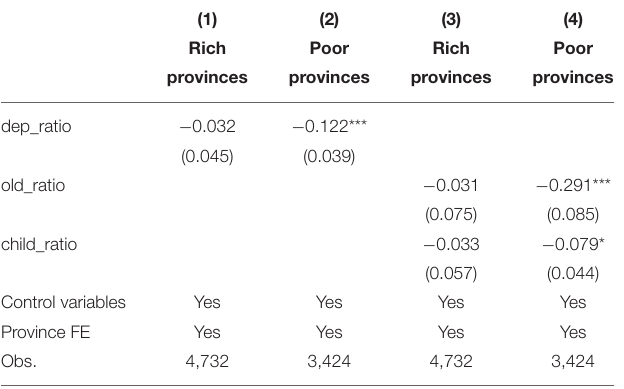
TABLE 5 | Regression results for regional heterogeneous effect. TABLE 6 | Mechanism